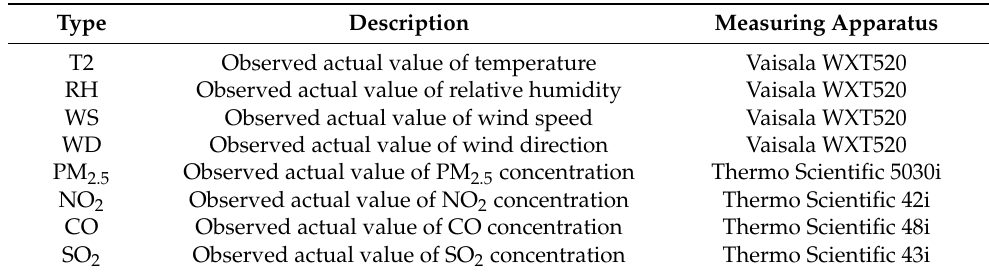
Table 3. Details of the meteorological elements and pollutant